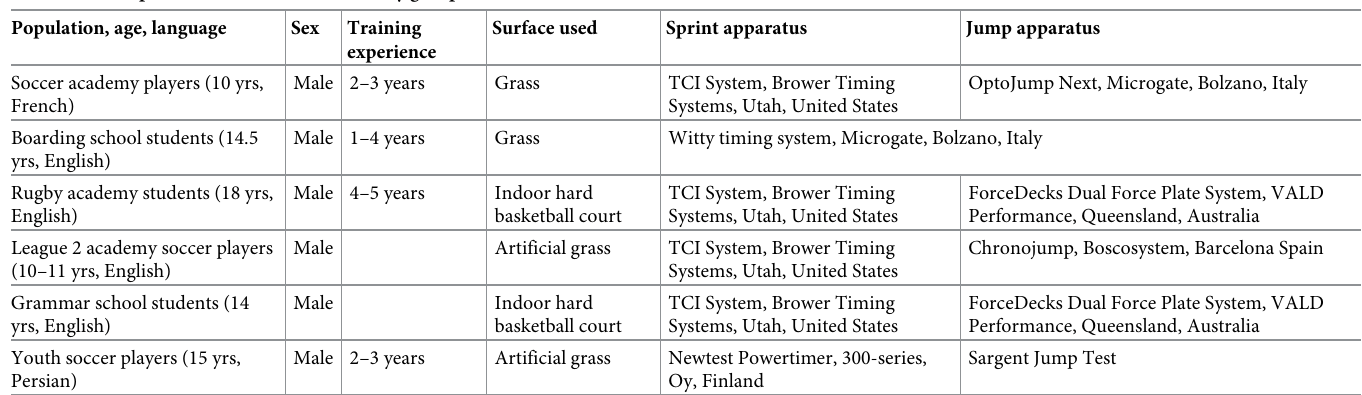
Table 1. Descriptive characteristics of the study groups.